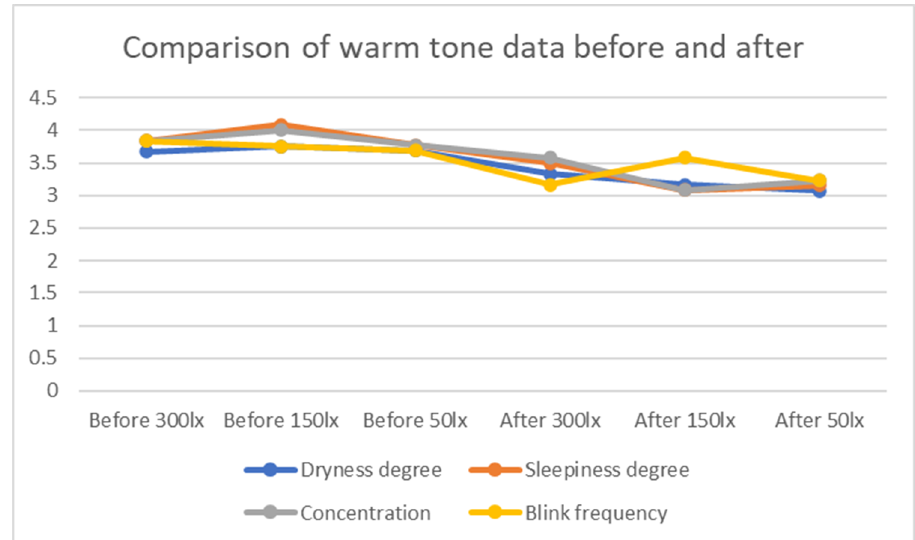
Figure 4. Line chart of visual fatigue rating before and after the experiment under three illumination levels in the warm tone paintings.